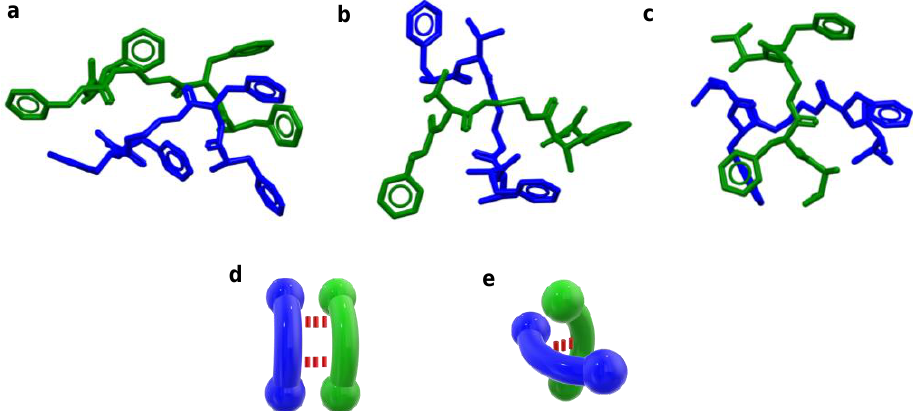
Figure 5. The most stable conformations (Spartan08′ , MMFFaq) obtained for the dimers of ( a ) 6b , ( b ) 6e , and ( c ) 6f ; ( d ) a representation of the parallel β -sheet; and ( e ) the tangled dimeric assemblies.